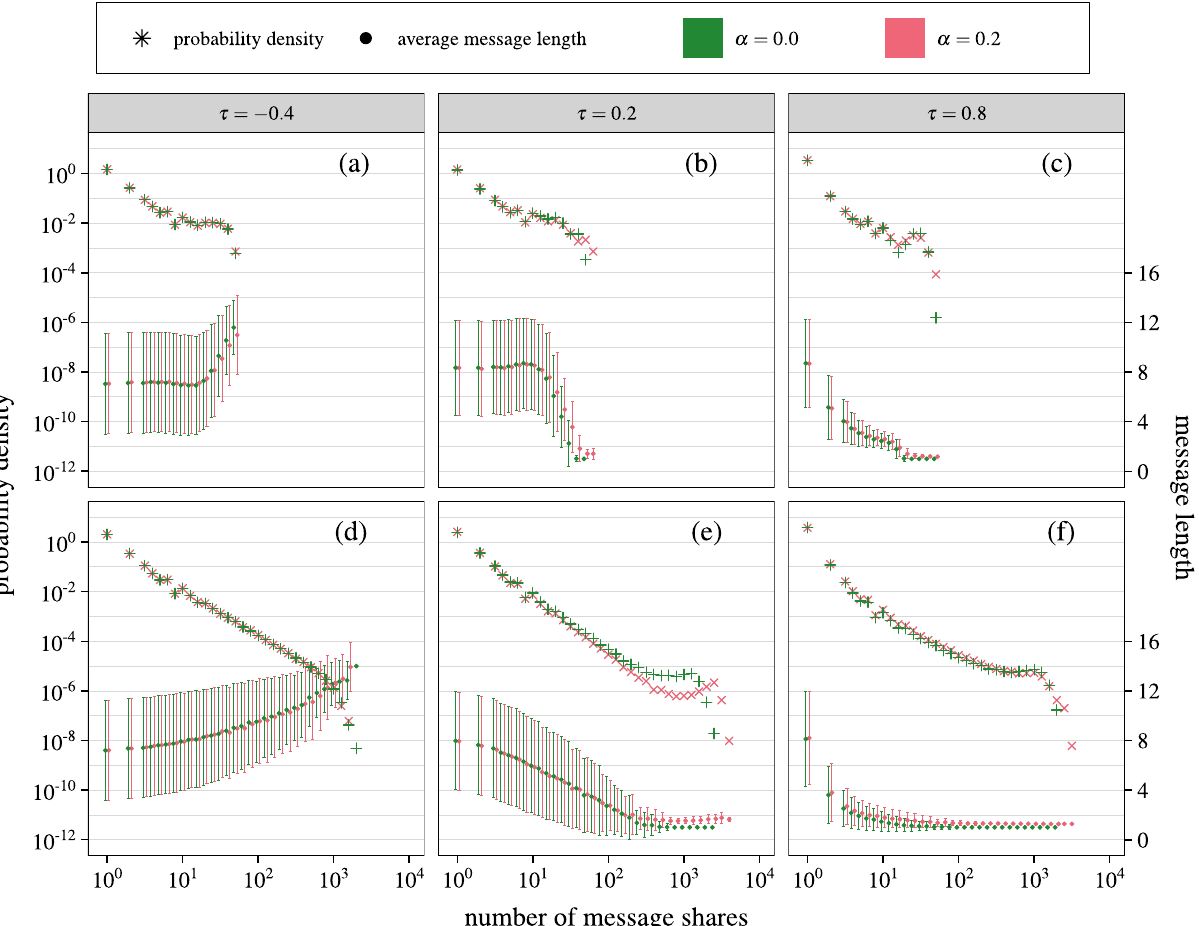
Figure 3. The model behaves in a similar fashion for networks of different sizes. The figure presents the influence of user selectivity τ and message adaptivity α on the popularity and average length of messages propagating in synthetic BA networks. Panels ( a )–( c ) shows message spreading for small networks N = 60 with 50, 000 time steps. Panels ( d )–( f ) are for a large BA networks N = 6000 with 5, 000, 000 time steps. Other parameters are the same as in Fig. 2. Columns correspond to different selectivity τ = − 0.4 , 0.2, 0.8, green symbols are for simulations without adaptivity ( α = 0 ) while red are with adaptivity ( α = 0.2